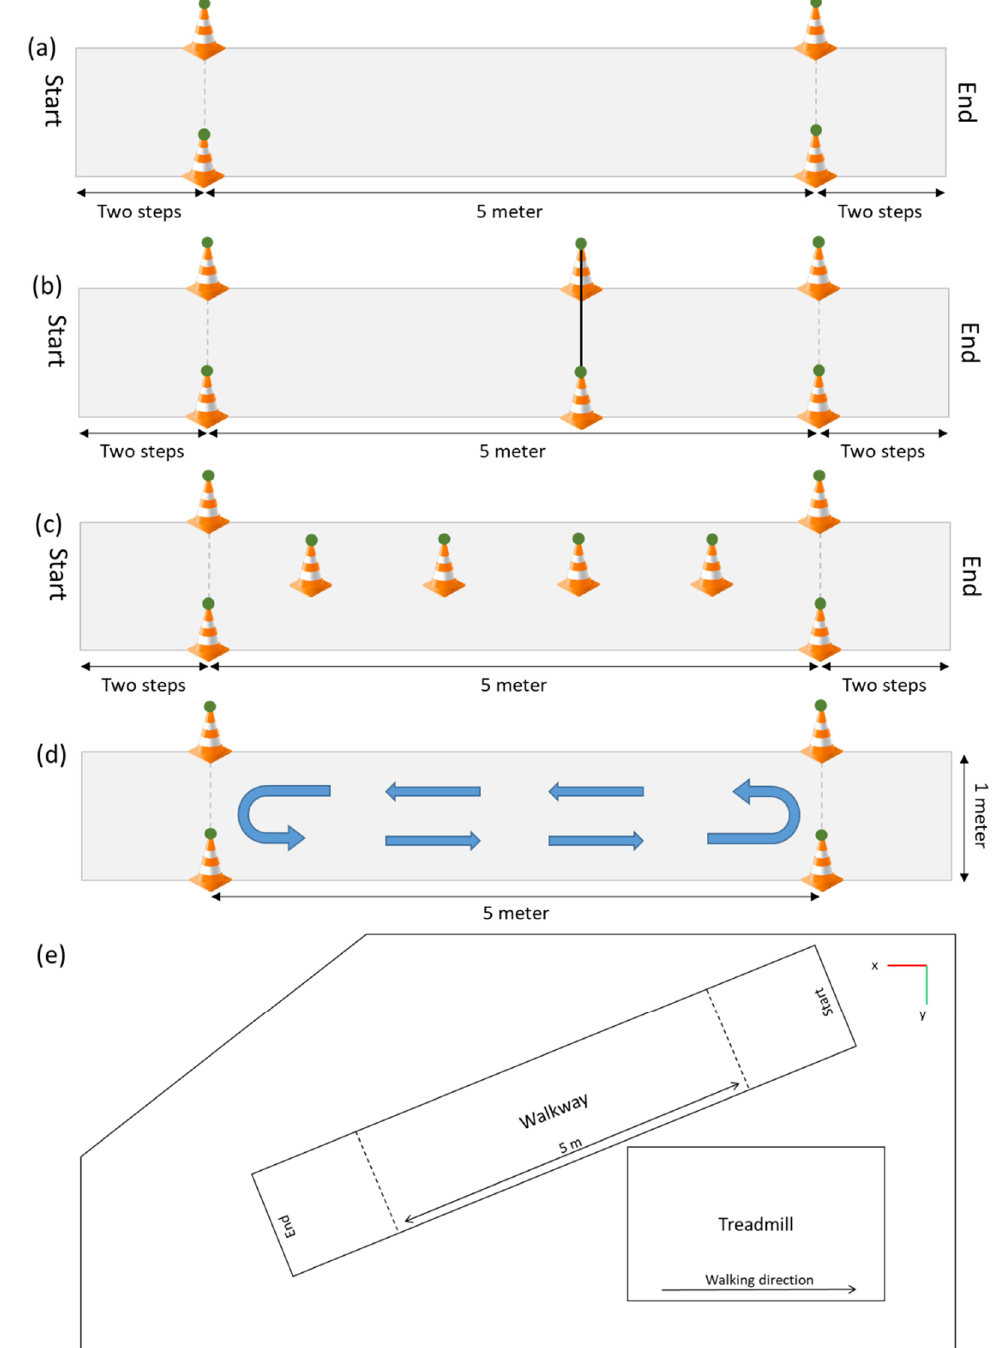
Figure 3. The walkway for the different over ground walking trials. ( a ) The walkway without any extra attributes, ( b ) The walkway with the obstacle, ( c ) The walkway for the slalom assessment, ( d ) The walkway for the dual-tasking assessments. The green circles represent the reflective markers captured with the optical motion capture system. ( e ) Top view of the laboratory with the orientation of the optical motion capture system (right-handed coordinate system).